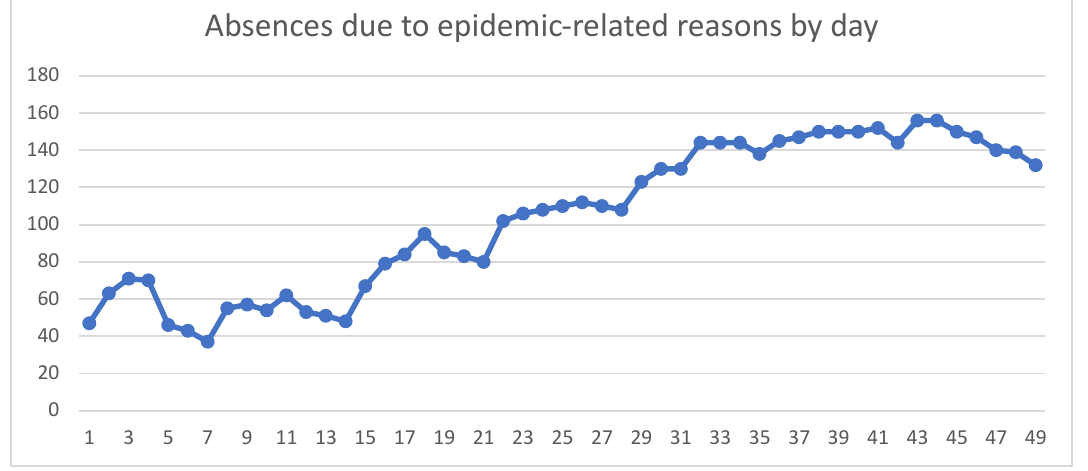
Figure 1. Employees on leave by day, for reasons related to the epidemic between 24 February 2020